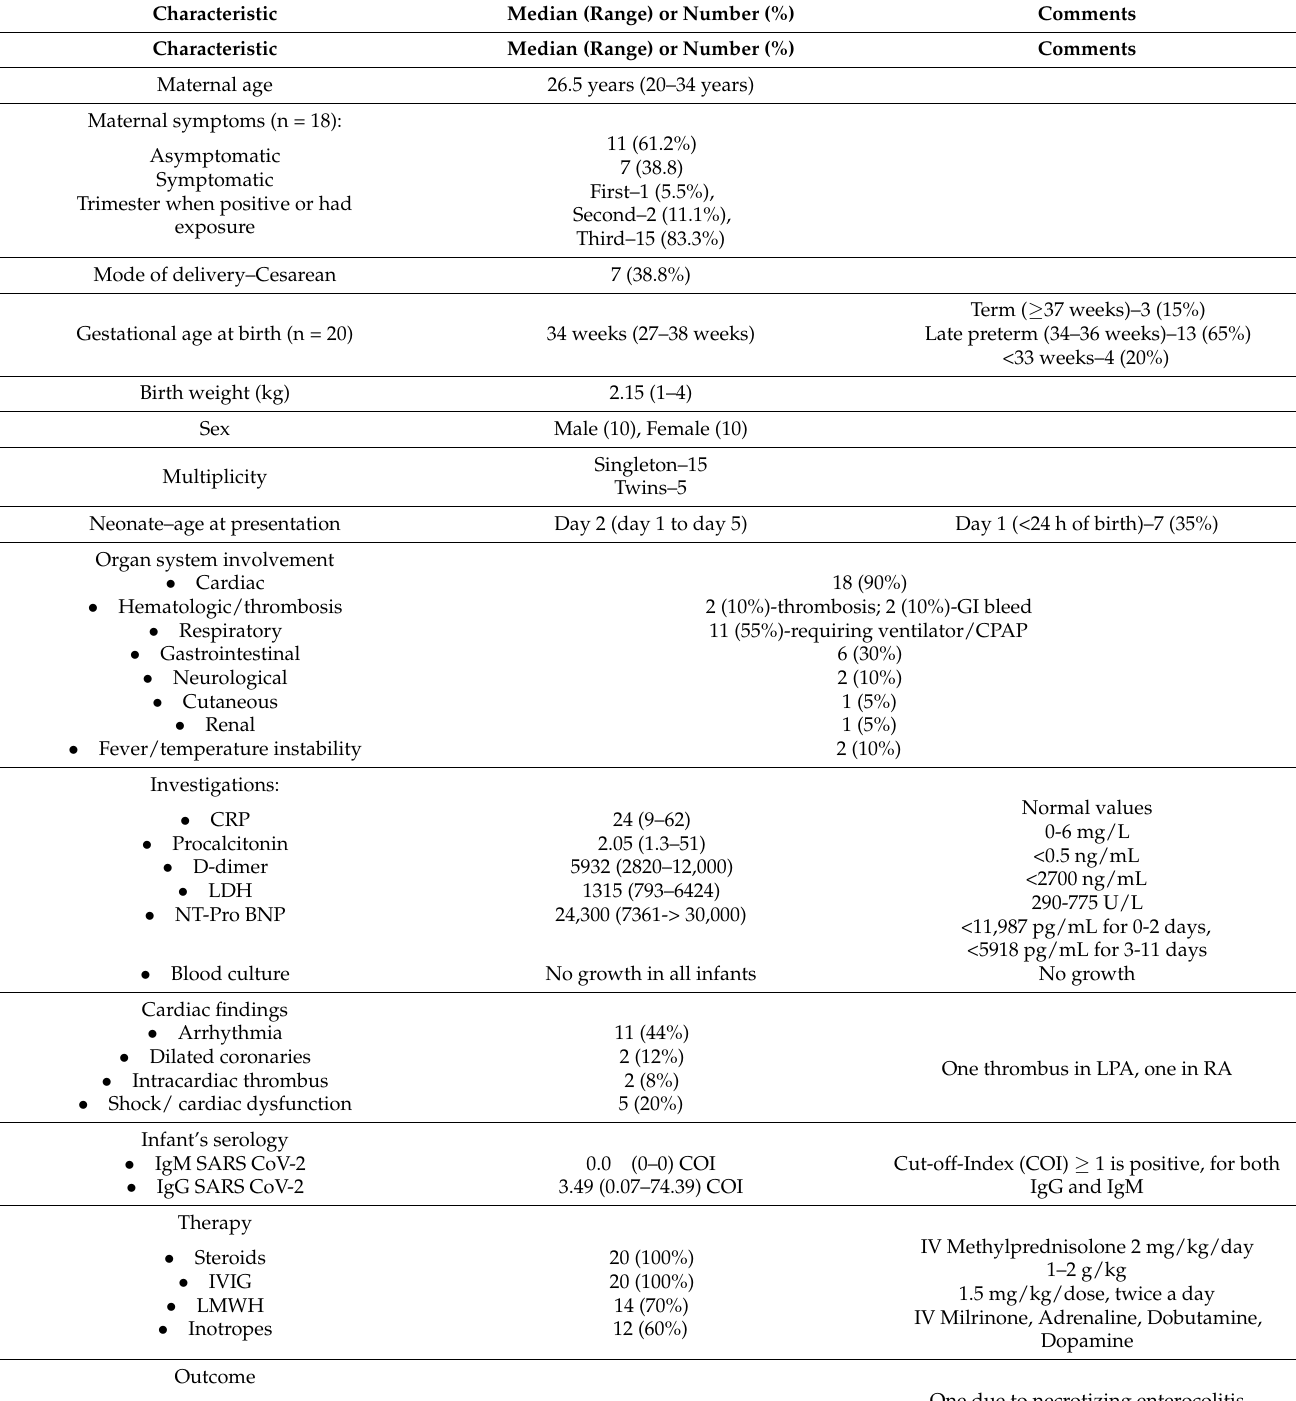
Table 2. Characteristics of patients with suspected